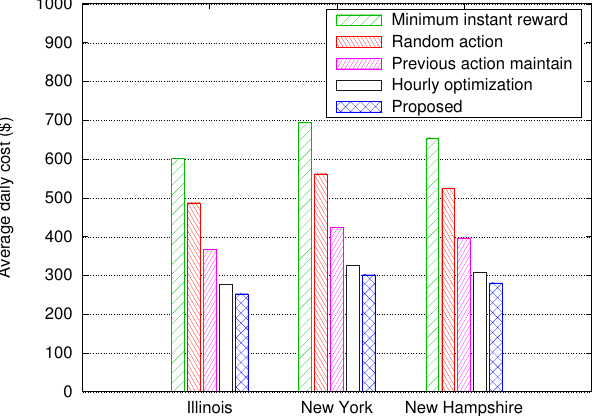
Figure 13. Average daily cost with real-time energy